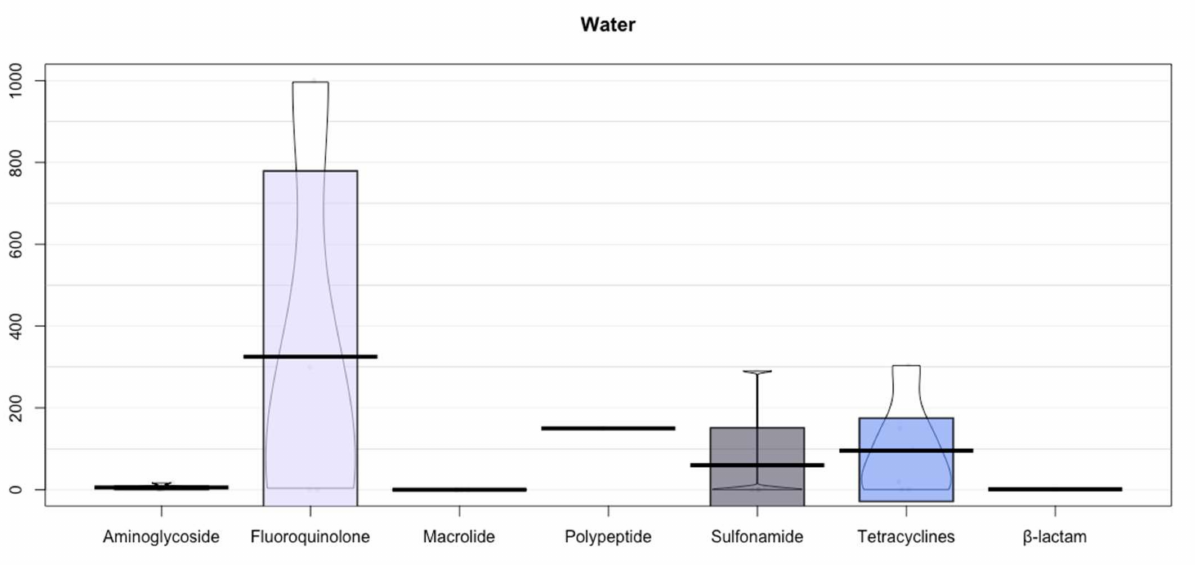
Figure 5. Antibiotic residues in water. Points represent the raw data; bar/line is the descriptive statistic (mean); bean is the smoothed density curve showing the full data distribution; and brackets represent the confidence